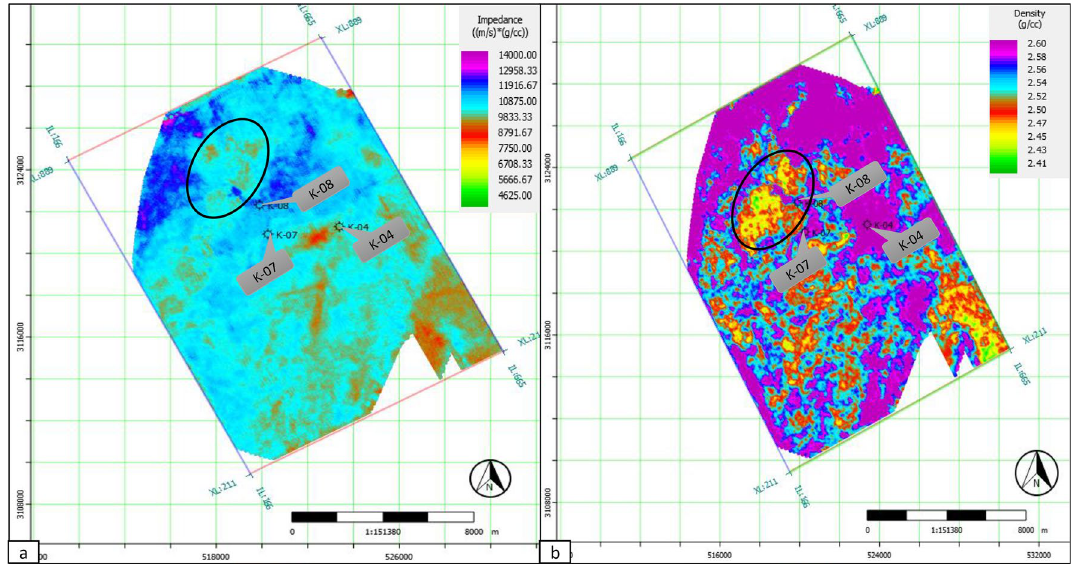
Fig. 15 Simultaneous pre-stack inversion results: a p -impedance cross section passing through three wells corresponding to delineate reservoir (S1) and b inverted density along the same cross section. Base map (upper left corner) shows profile of the cross section